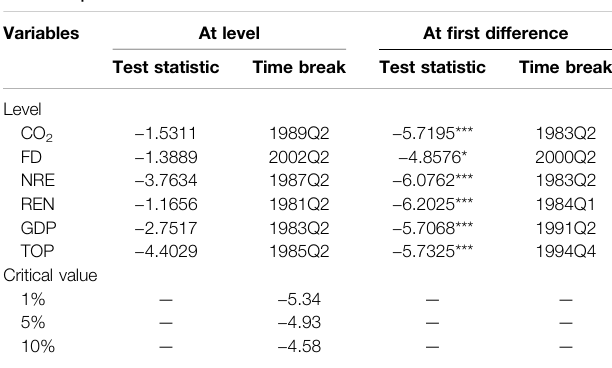
TABLE 3 | Unit root test